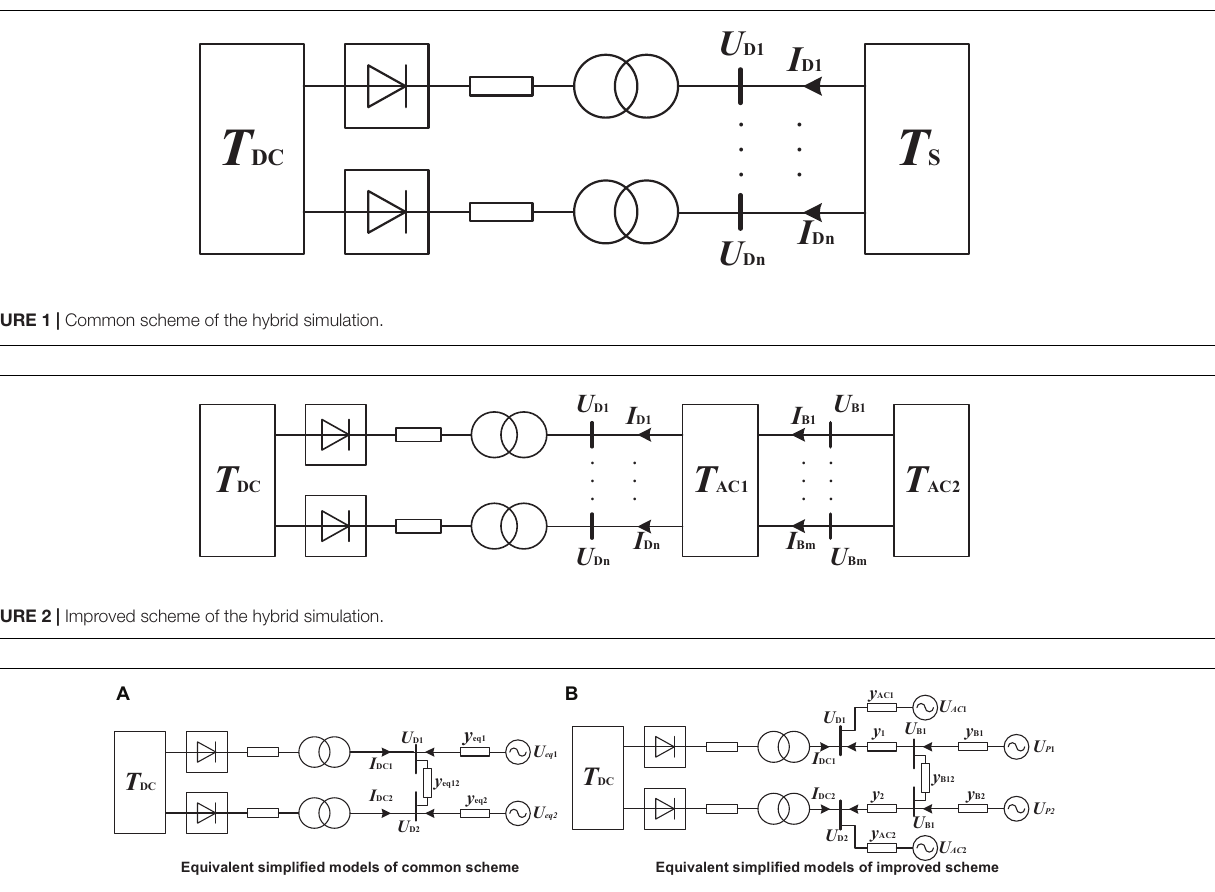
FIGURE 3 | Schematic diagram of the hybrid simulation scheme. (A) Equivalent simplified models of the common scheme. (B) Equivalent simplified models of the improved scheme.